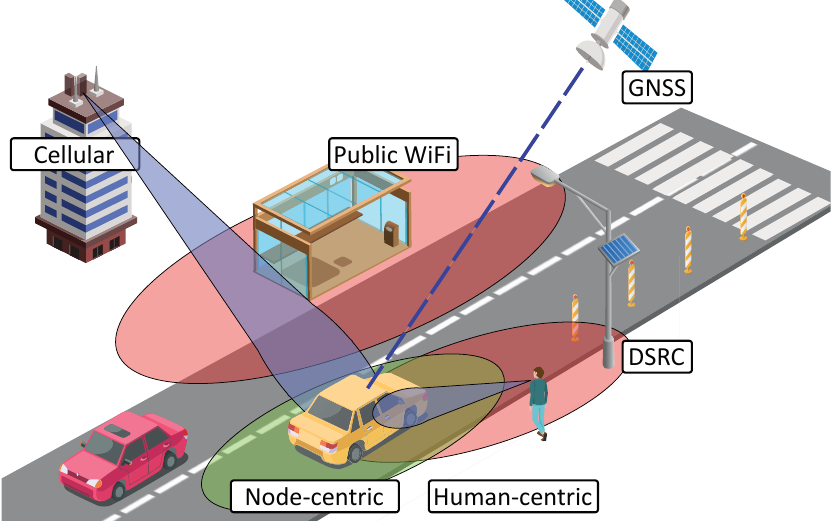
Figure 1. General example of vehicular positioning